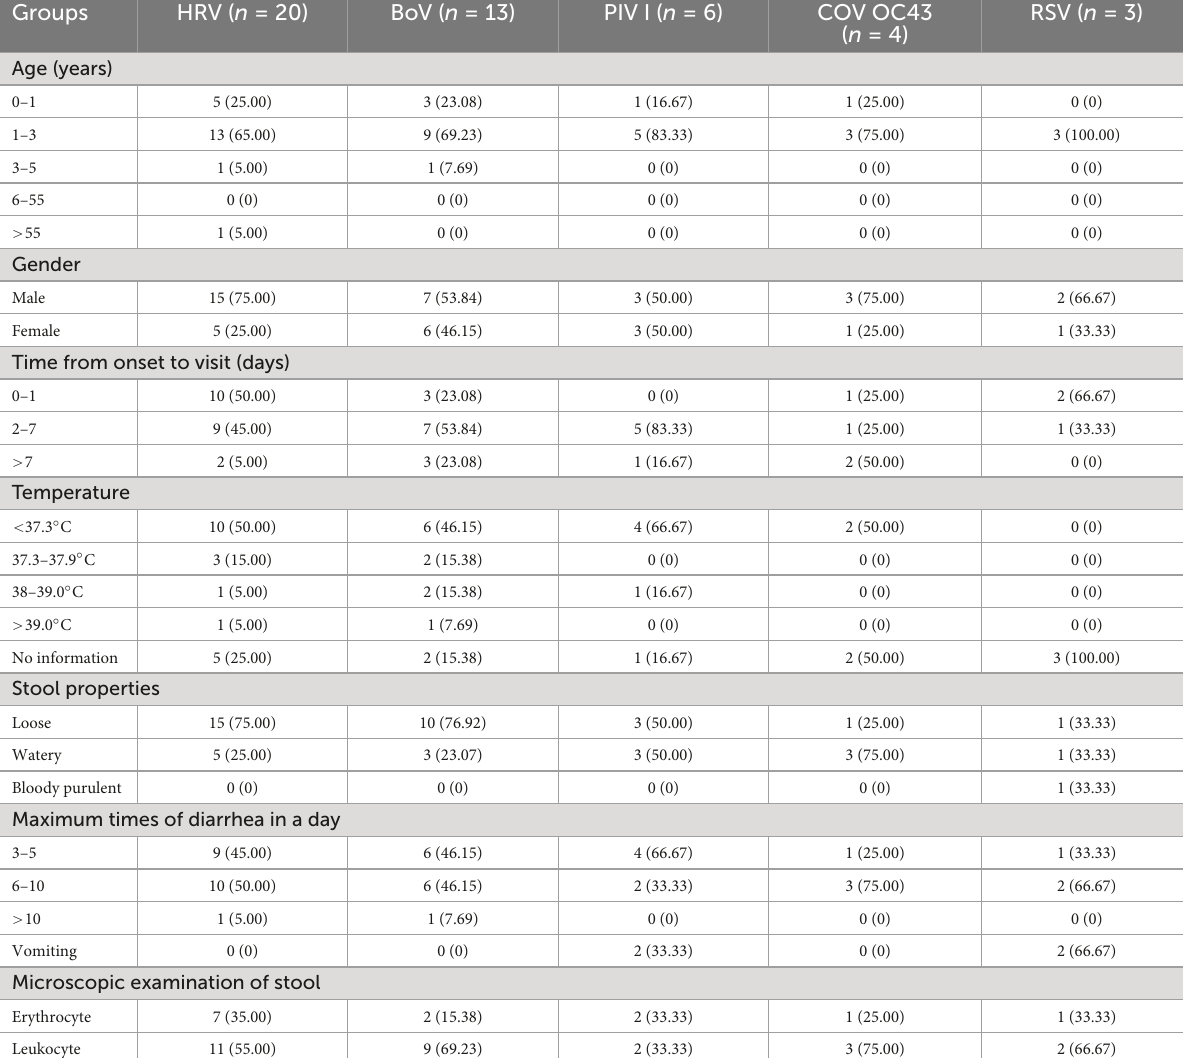
TABLE 2 The clinical characteristics of respiratory viruses infections among diarrhea cases in enteric disease clinics in Beijing from 2019 to 2020.